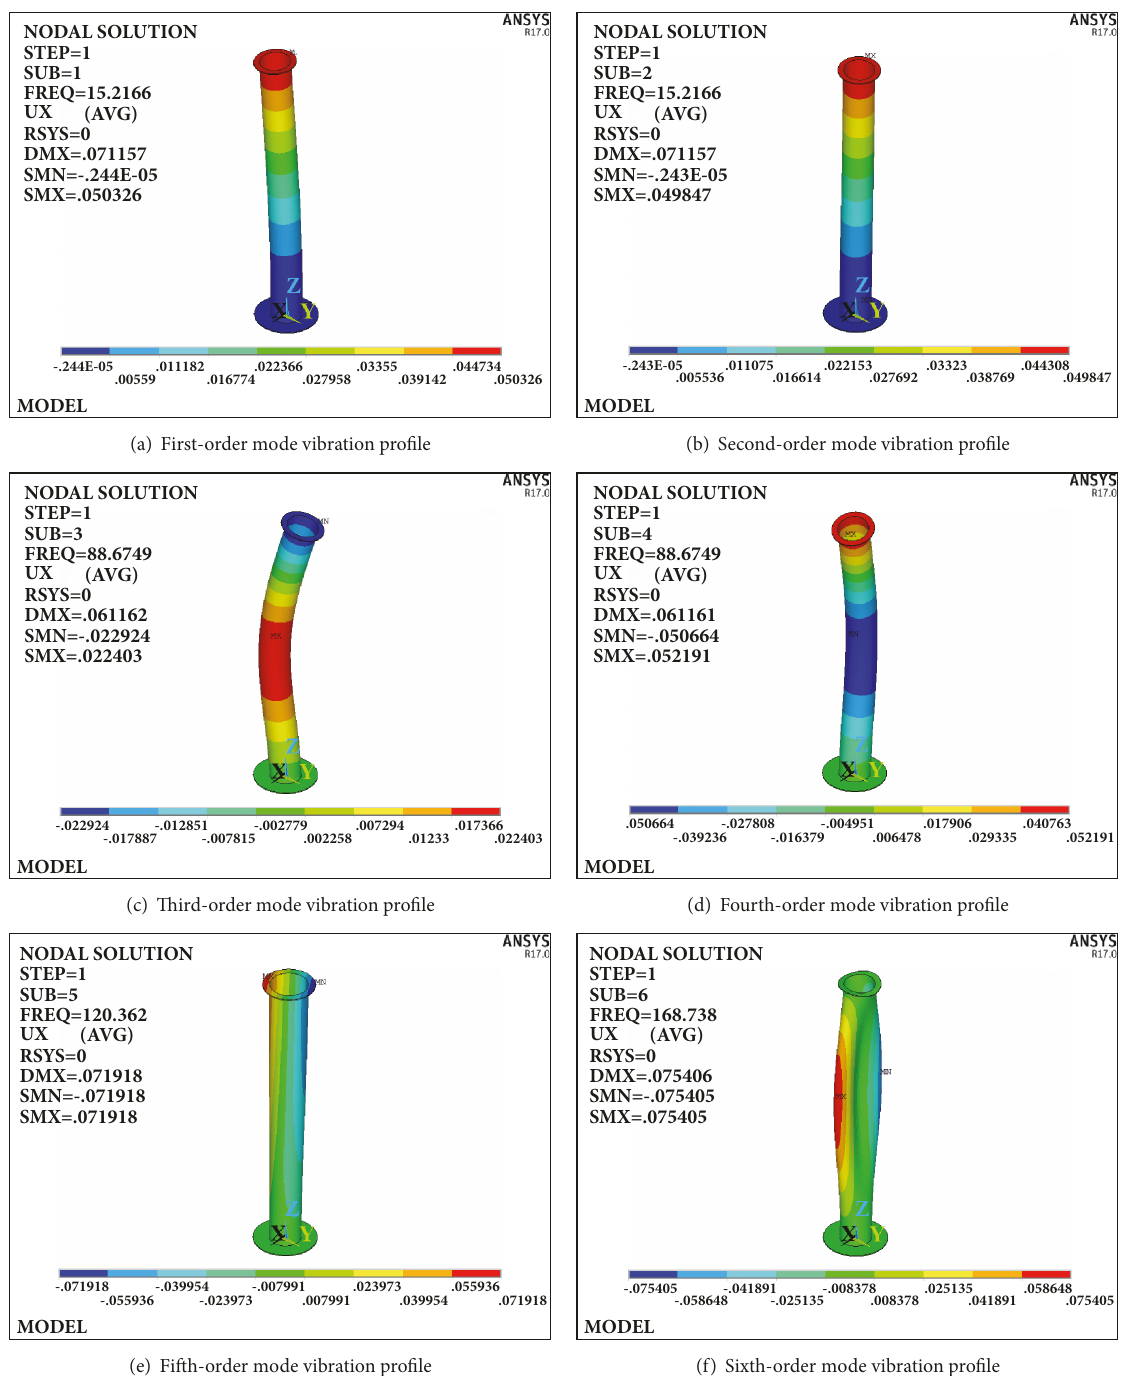
Figure 18: The first six-order mode vibration profile of